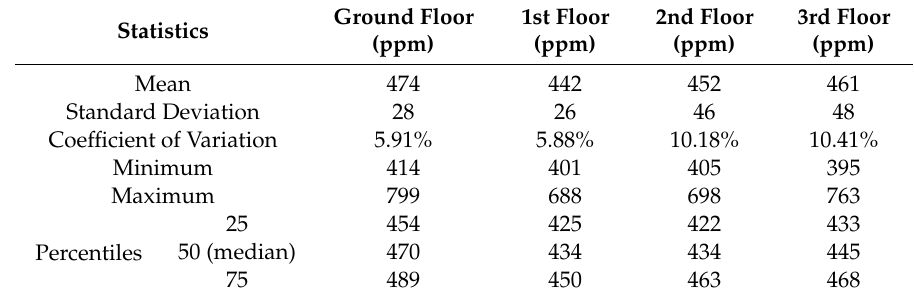
Table 4. Descriptive statistics for CO 2 in each floor, for all experimental periods (April 2018–March 2019).